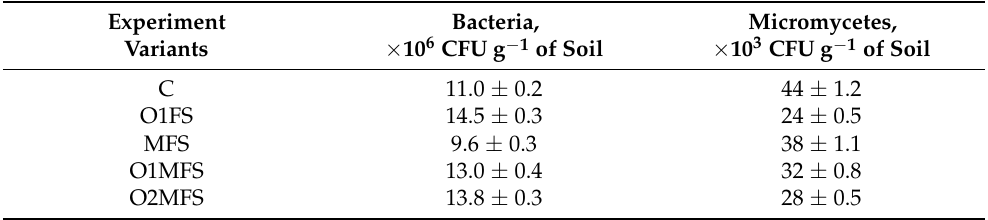
Table 3. The total number of the main taxonomic groups of microorganisms in the sod-podzolic soil of the studied crop rotation averaged from 2019–2021.